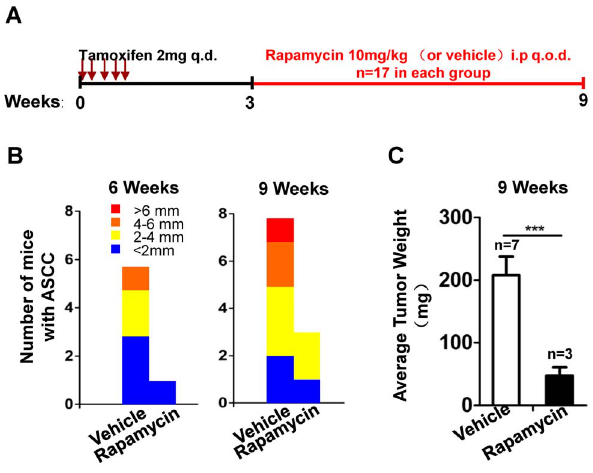
Figure 5. Inhibition of mTOR by rapamycin treatment blocks ASCC progression in Tgfbr1/Pten 2cKO mice. (A), a schematic showing a rapamycin treatment used in the chemopreventive experiment in Tgfbr1/Pten 2cKO mice. (B), reduced tumor burden in Tgfbr1/Pten 2cKO mice by rapamycin treatment as compared with vehicle group 6 weeks (left panel) and 9 weeks (right panel) after tamoxifen induction, respectively The total tumor number of tumors observed is calculated from 17 mice in each group. (C), average ASCC tumor weight in rapamycin- and vehicle- treated groups at 9 week is calculated using Graph pad Prisim5. Mean 6 SEM; *, P , 0.05; **, P , 0.01; ***, P , 0.001; Student t test. i.p., intra-peritoneal, q.o.d., every other day; rapamycin group, n=17, vehicle group,